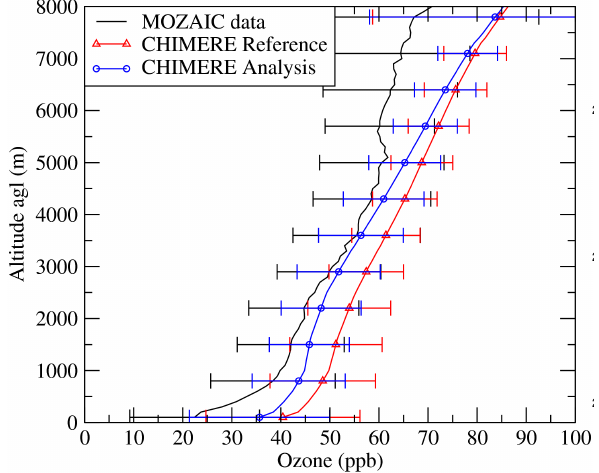
Fig. 16. Assimilation with CHIMERE of ozone profiles recorded by the IASI instrument and comparisons of the obtained gain with MOZAIC data (Data courtesy of A.Coman).